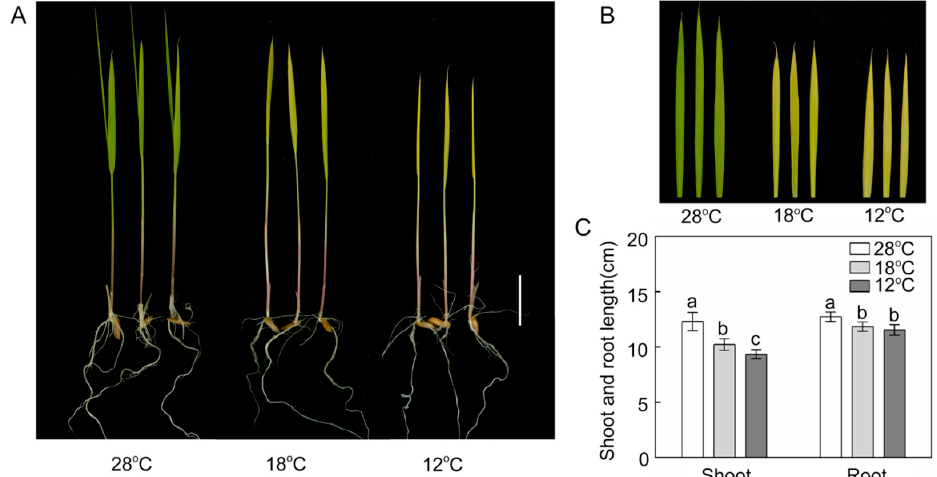
Figure 1. E ff ect of chilling stress on rice seedling growth ( A , B ) and shoot / root length ( C ) after 48 h Figure 1. Effect of chilling stress on rice seedling growth ( A , B ) and shoot/root length ( C ) after 48 h of of greening. Six day old etiolated seedlings were treated with 18 ◦ C or 12 ◦ C chilling stress. Date greening. Six day old etiolated seedlings were treated with 18 °C or 12 °C chilling stress. Date represent means ± SD of 10 replicate samples. Bars with di ff erent letters above the columns of figures represent means ± SD of 10 replicate samples. Bars with different letters above the columns of indicate significant di ff erences according to Duncan’s multiple range test at p < 0. Bar = 2 figures indicate significant differences according to Duncan’s multiple range test at p < 0. Bar = 2 cm.